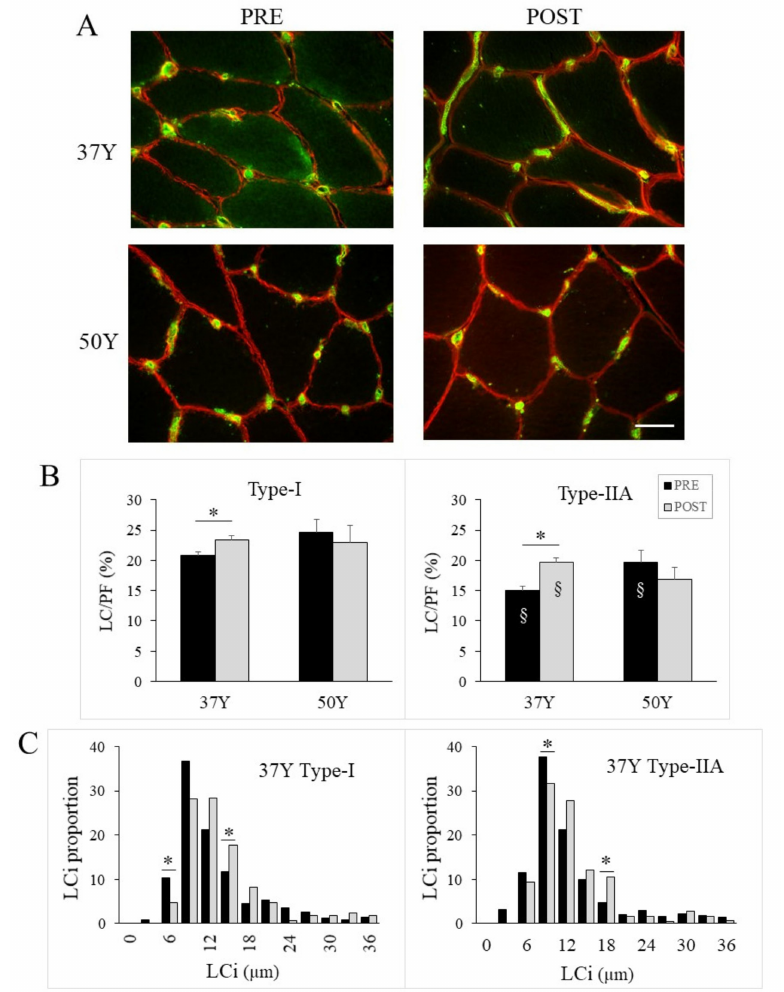
Figure 4. Muscle capillarization. ( A ) Representative images of cross-sections labeled with anti-CD31 antibody for 37Y and 50Y runners PRE- and POST-24TR; the scale bar represents 20 µ m. ( B ) The functional surface of exchange between capillaries and muscle fibers (LC/PF) is expressed as a percentage of fiber perimeter in contact with capillaries for middle-aged (37Y) and master (50Y) runners PRE (black bars) and POST (gray bars) 24TR. Statistical interaction between time and group was p = 0.001 for type-I and p = 0.003 for type IIA fibers. ( C ) Frequency histogram of the length of contact of each capillary (LCi) for type-I (left) and type-IIA fibers (right) in PRE (black) and POST (gray) muscles of 37Y runners. * p < 0.05 between PRE and